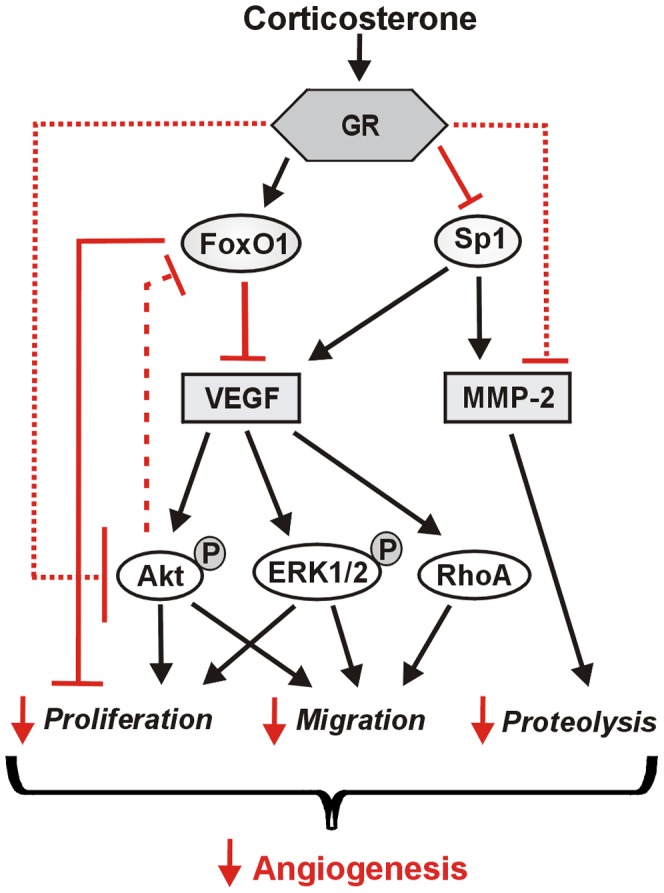
Corticosterone inhibits multiple pathways to repress angiogenesis.Corticosterone, acting through the glucocorticoid receptor (GR), increases FoxO1 and reduces Sp1 levels. Together with cytostatic effects through targeting cell cycle inhibitors, we showed that FoxO1 represses VEGF mRNA levels. The downregulation of Sp1 will lead to a decrease in the levels of its transcriptional targets, which are known to include both VEGF and MMP-2. The reduction in VEGF will contribute to the lower activation of ERK1/2, Akt and RhoA GTPase, in turn influencing endothelial cell proliferation and migration. Corticosterone-mediated GR activation also may influence these proteins independently of the effects on FoxO1 and Sp1 (dotted lines). Akt exerts an inhibitory influence on FoxO1 protein (dashed line), thus the reduction in Akt activation will relieve this suppressive effect and promote higher levels of FoxO1 protein. Reduced production and activation of MMP-2 contributes to a decrease in proteolysis required for cell sprouting. The combined inhibitory effects on proliferation, migration and proteolysis effectively curtail the process of angiogenesis. Inhibitory influences are highlighted with red lines.